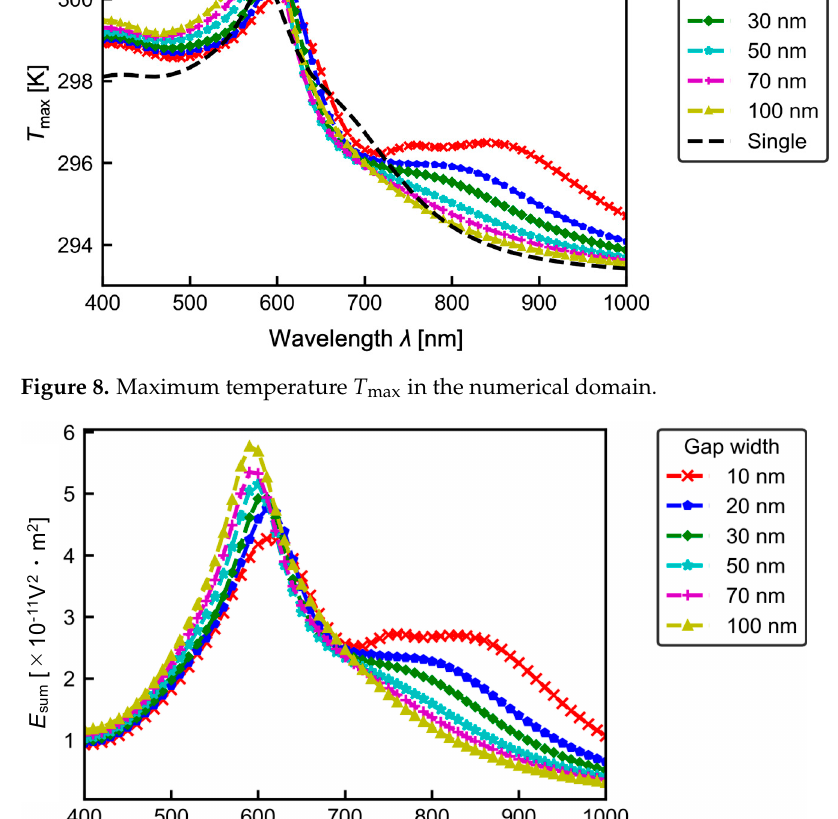
Figure 9. Volume integral of | E| 2 , E sum , inside the gold nanostructures.